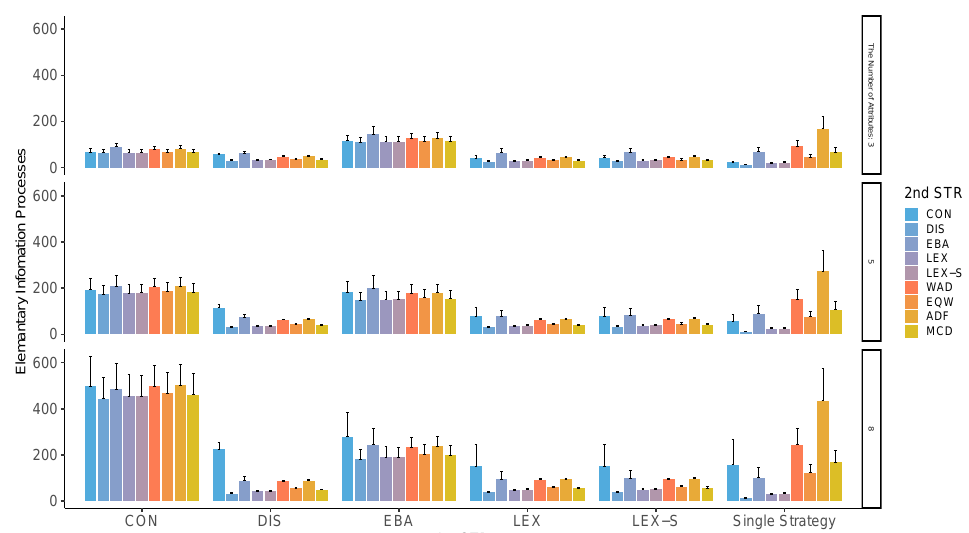
Figure A19. Average EIPs in two-stage decision-making when only two alternatives are left in the second stage for the different numbers of attributes. Note: ADF: additive difference; CON: conjunctive; DIS: disjunctive; EBA: elimination by aspects; EQW: equal-weighted strategy; LEX: lexicographic; LEX-S: lexicographic semi-order; MCD: majority of confirming dimensions; STR: strategy; WAD: weighted additive.